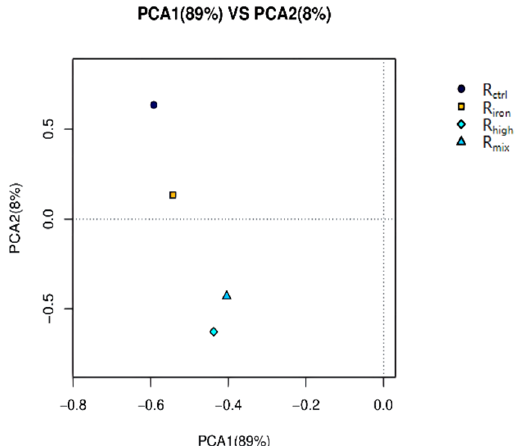
Figure 6. Principal component analysis from different reactors. PC1 and PC2 are the principal components 1 and 2, which represent 66.3% and 17.0% of community variation, respectively (based on weighted UniFrac